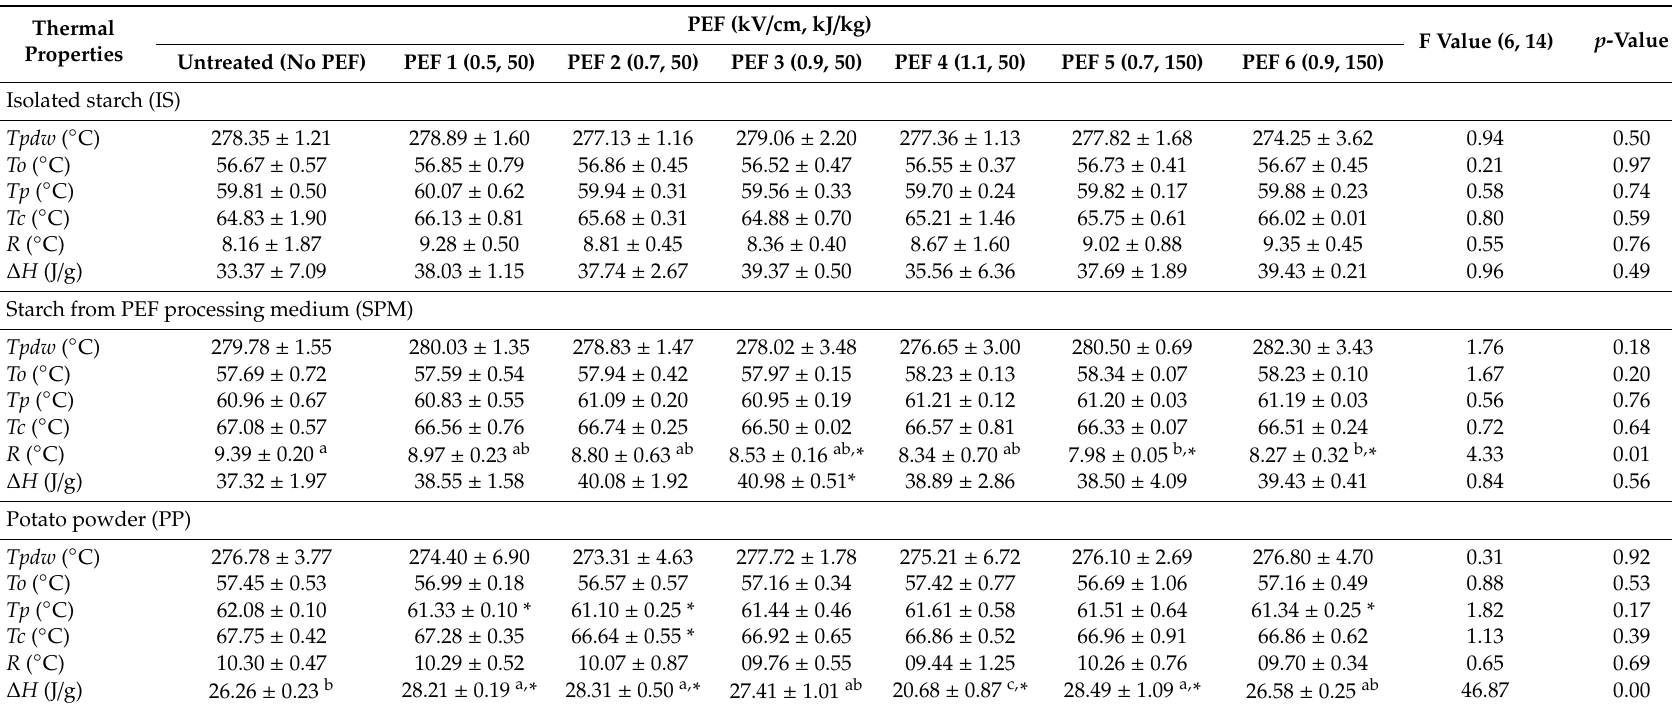
Table 2. Thermal stability and gelatinisation temperature of isolated starch (IS), starch from PEF processing medium (SPM), and potato powder (PP) from PEF treated